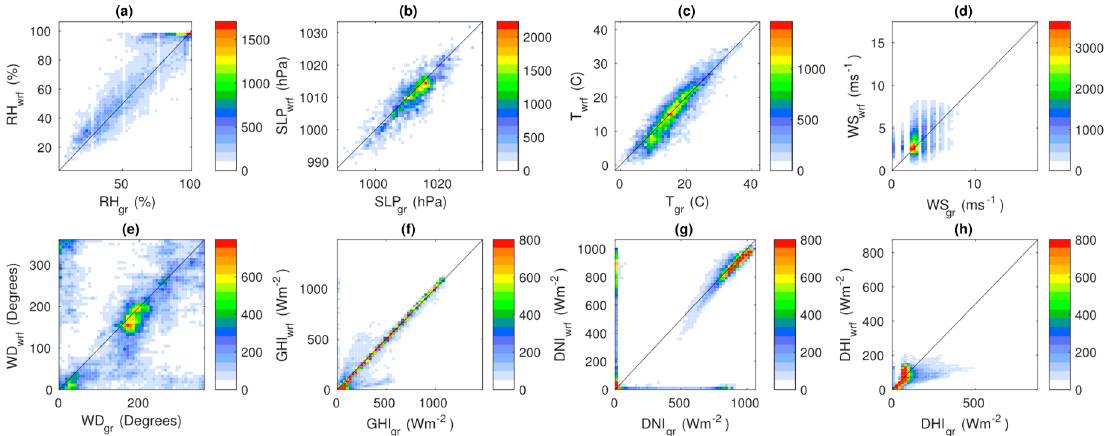
Figure 11. Density (shaded) scatterplots of measured and modelled surface (( a ) RH, ( b ) SLP, ( c ) T, ( d ) WS, ( e ) and WD) and solar irradiance (( f ) GHI, ( g ) DNI, and ( h ) DHI) variables using WRF-Solar at 45 km grid spacing.